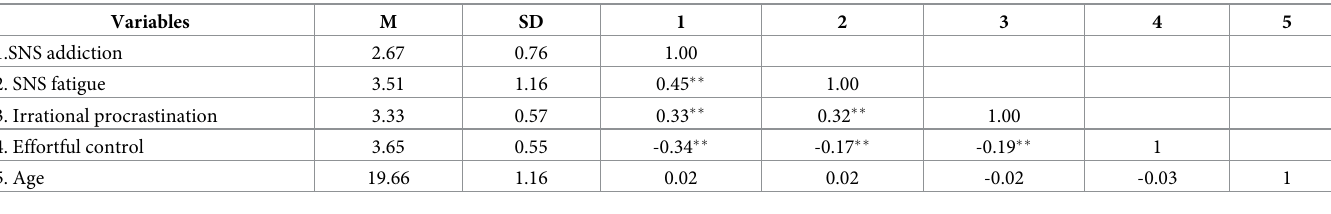
Table 1. Descriptive statistics and interrelations among all of the observed variables and age.